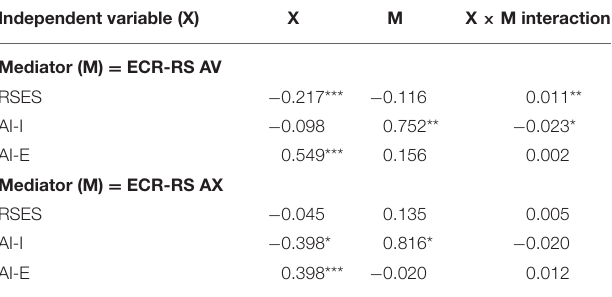
TABLE 3 | Mediation effects of attachment avoidance and attachment anxiety on the self-esteem/motivation to the effect of the acceptance of sugar relationships in younger participants ( n = 1,980); unstandardized coefficients.